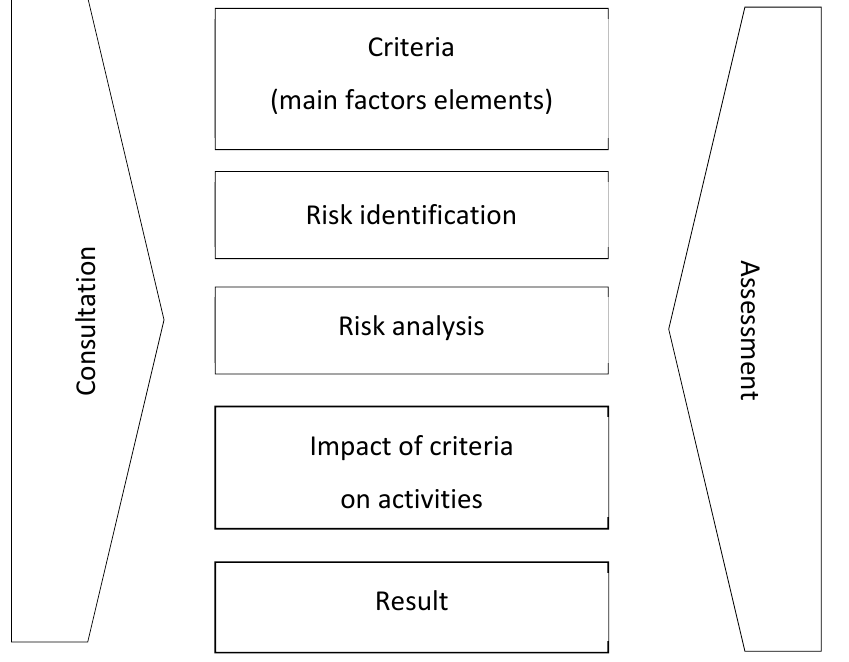
Figure 1. Risk management process flow chart. (Source: own study based on data from ISO 31000: 2018). The analysis presented concerns the actions of a police officer on the site of a traffic incident. The risk matrix recommended by the Police Commander in Chief was adopted for this